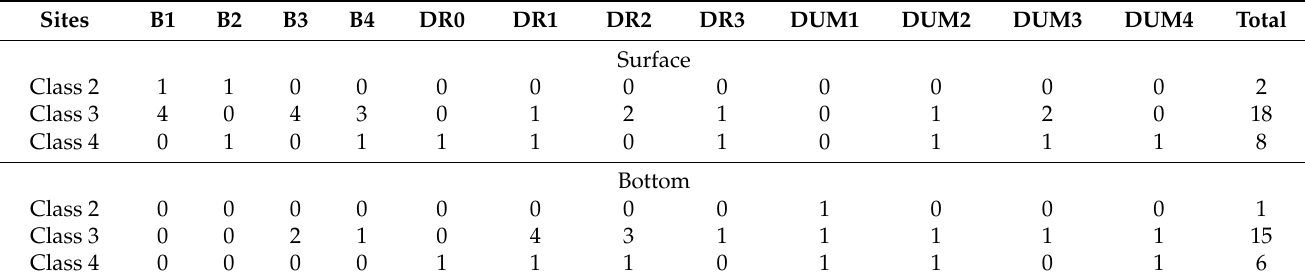
Table 5. Number of species indicating the affiliation to water quality class by the index of saprobity (SLA). Sites